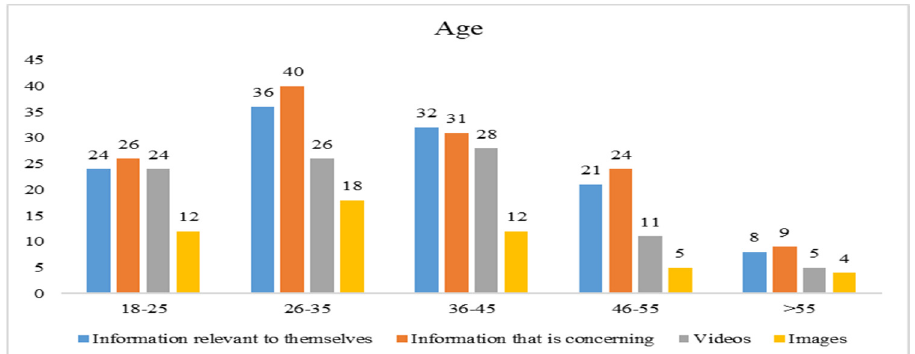
Figure 3. Age distribution of the study respondents.